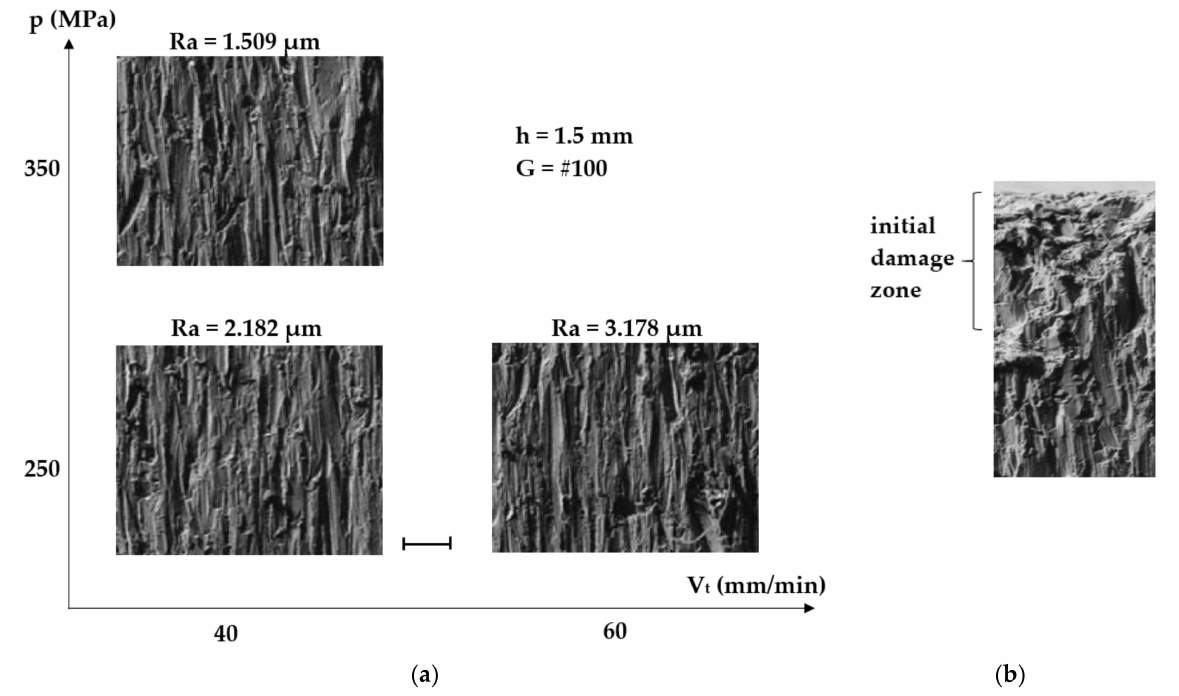
Figure 4. AWJ-machined surface: ( a ) traces; ( b ) initial damage area.